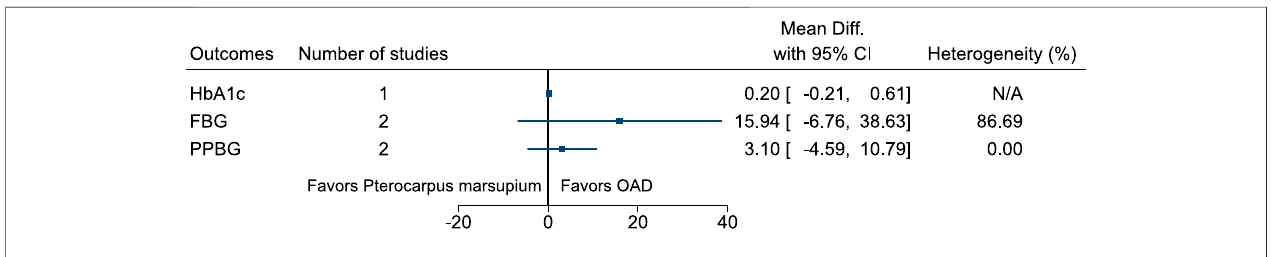
FIGURE 27 | Pterocarpus marsupium (versus OAD) — Summary forest plot.